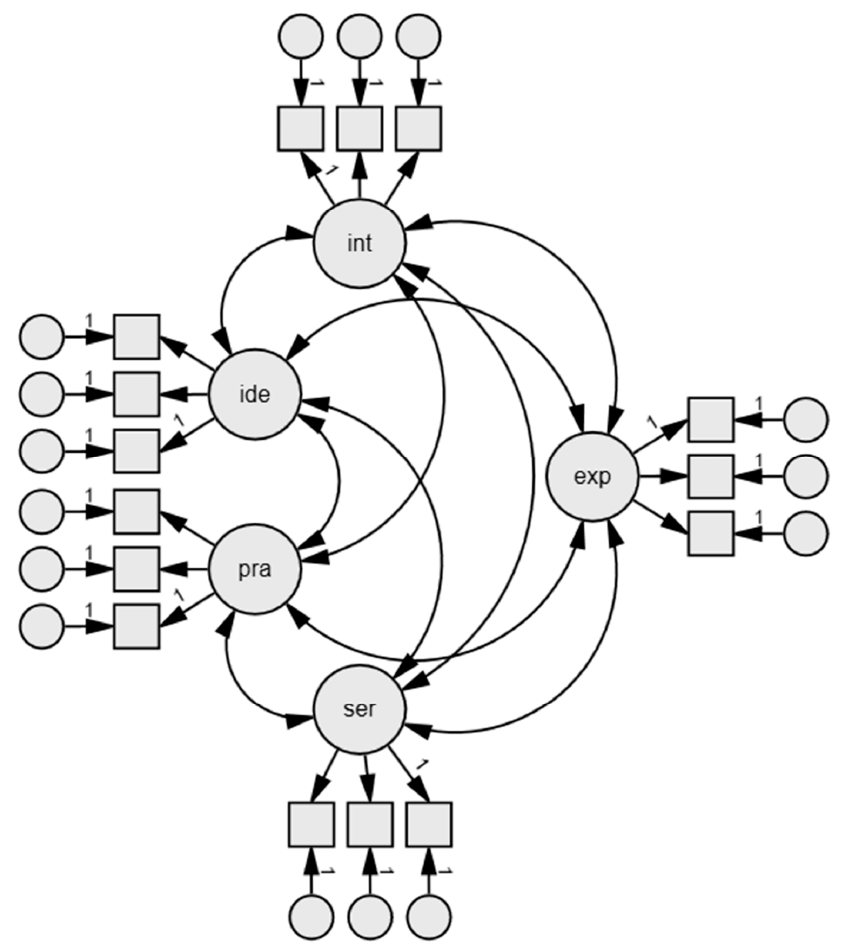
Figure 1. Symbolic picture of the basic model for the CRS. “int”—intelligence, “ide”—ideology, “exp”—experience, “pra”-private practice, “ser”—church attendance. Small circles depict residual variances, squares depict indicators, curved lines show covariances, straight lines show regressions.